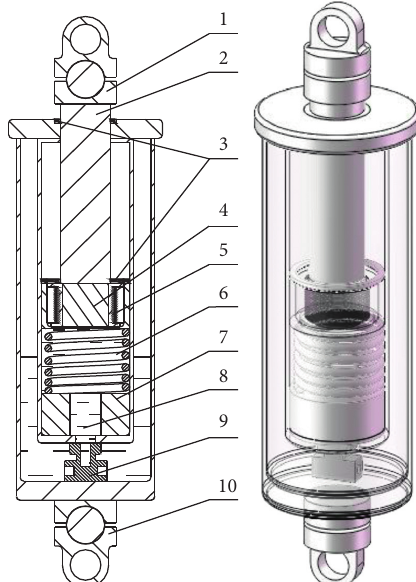
Figure 2: Structure model of the magnetoelectric hybrid suspension hydraulic damper.1, upper support; 2, piston rod; 3, sealing ring; 4, iron core; 5, coil; 6, spring; 7, permanent magnet; 8, hydraulic oil; 9, damping valve; 10, lower